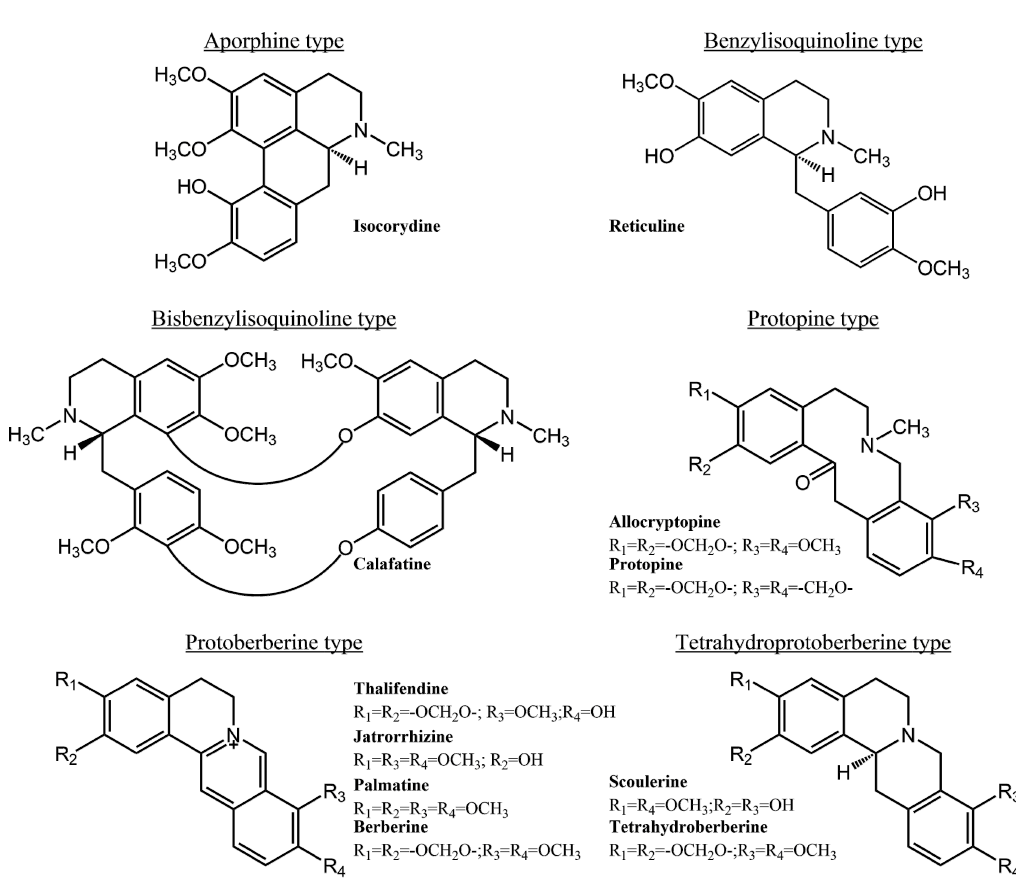
Figure 1. Isoquinoline alkaloids present in leaves, stems and roots of Berberis microphylla . Adapted from reference [6].